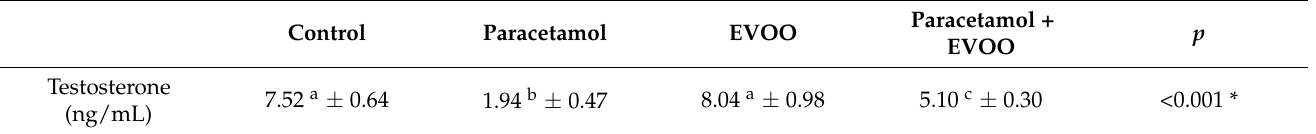
Data represented as mean ± SE. Different superscripts are significant. p : p value for F test (ANOVA) and significant between groups using post hoc test (LSD) *: Statistically significant at p ≤ 0.05 concentration in male rats. The values are expressed as means ± S.E ( n = 5), significant difference at p <